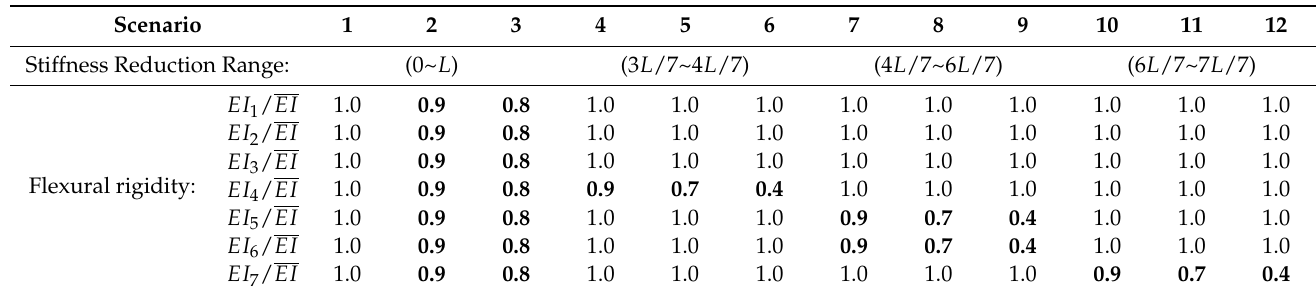
Table 1. The vehicle parameters. Table 3. The bridge’s stiffness distribution patterns.